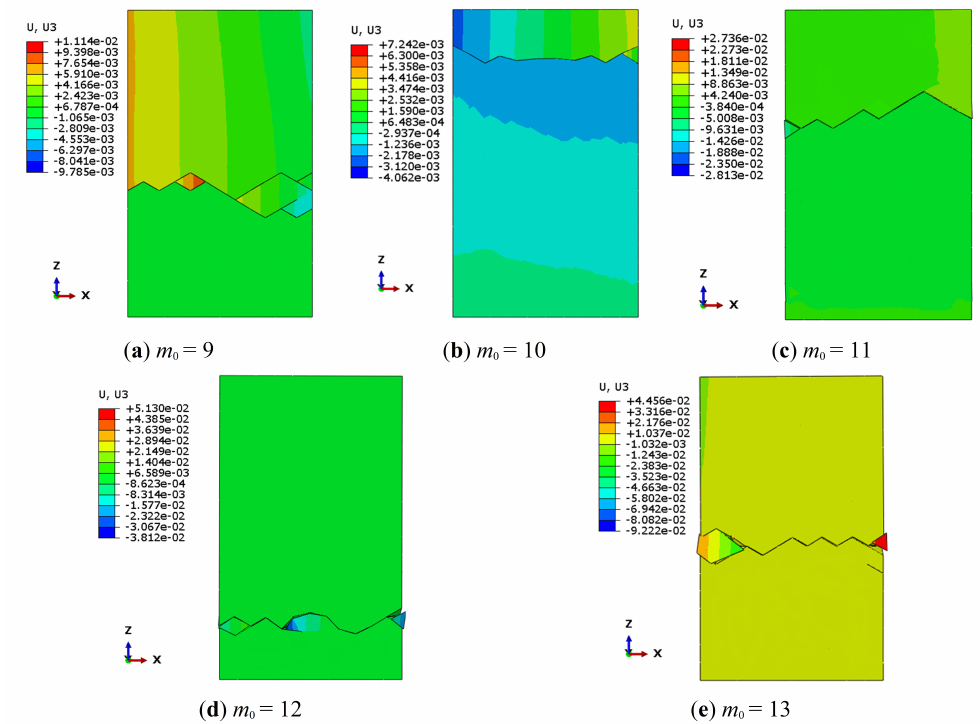
Figure 7. The failure pattern of the simulation results with different Weibull modulus ( m 0 = 9, 10, 11, 12, and 13). The U 3 legend in the figure indicates the displacement of the samples in the